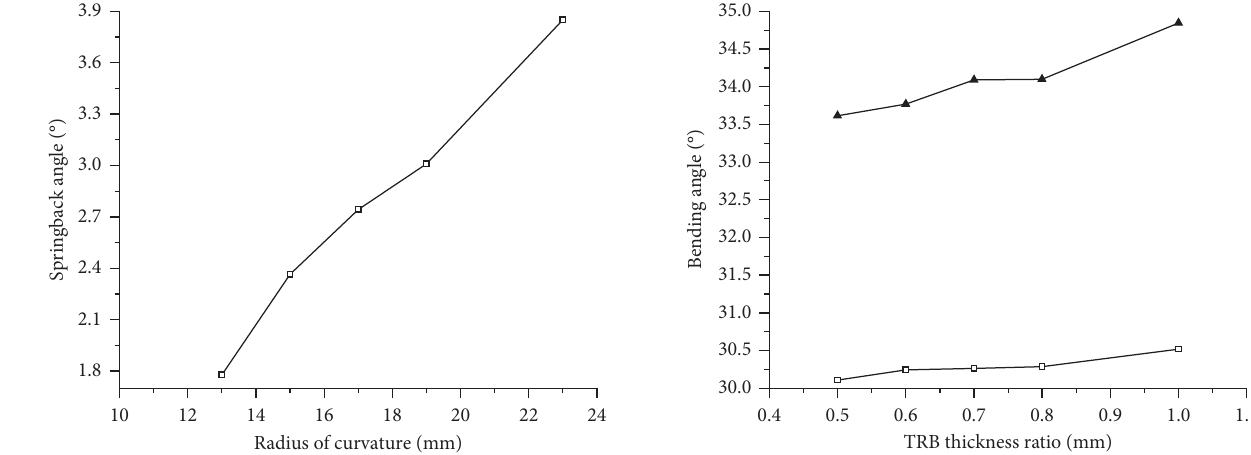
Figure 18: Curves of equivalent plastic strain after springback.